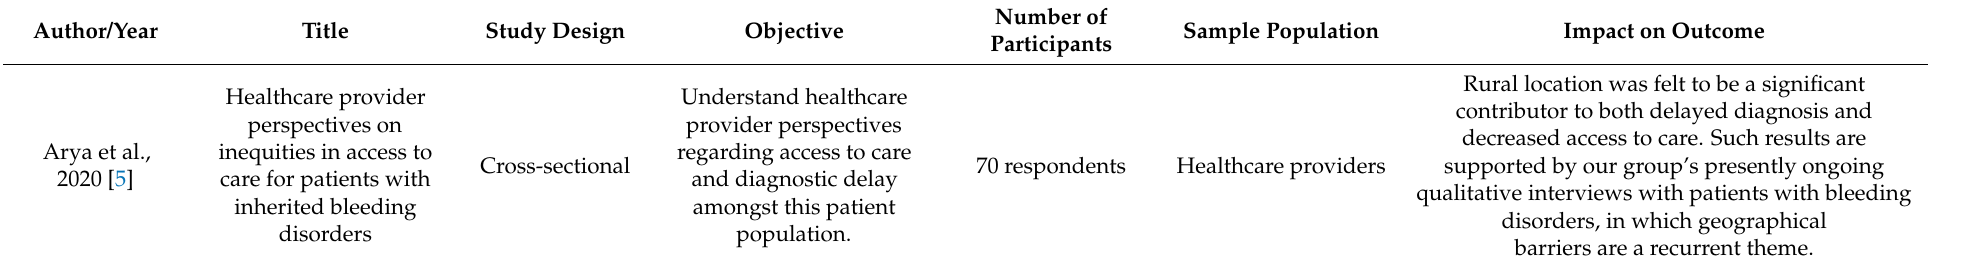
Table 3. Summary of articles found focused on Neighborhood and Physical Environment.